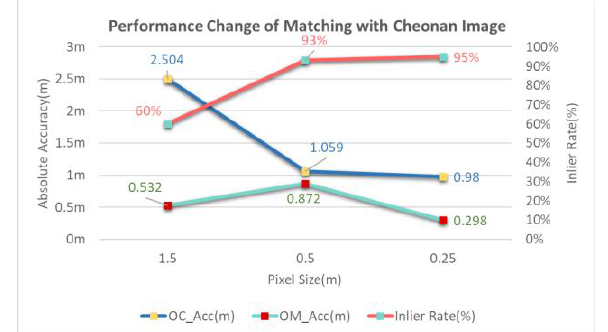
Figure 9. Performance change of matching with Yanggu RapidEye image.